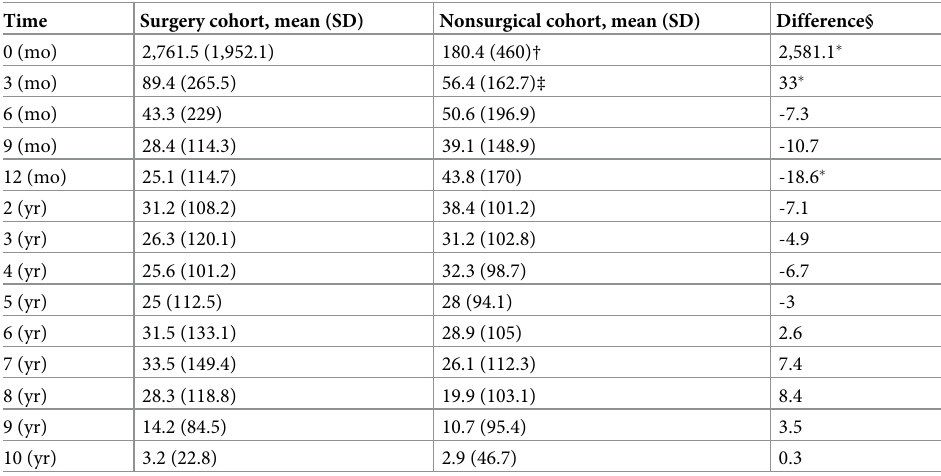
Table 4. The monthly cost after the initiation of treatment during each period (units, US